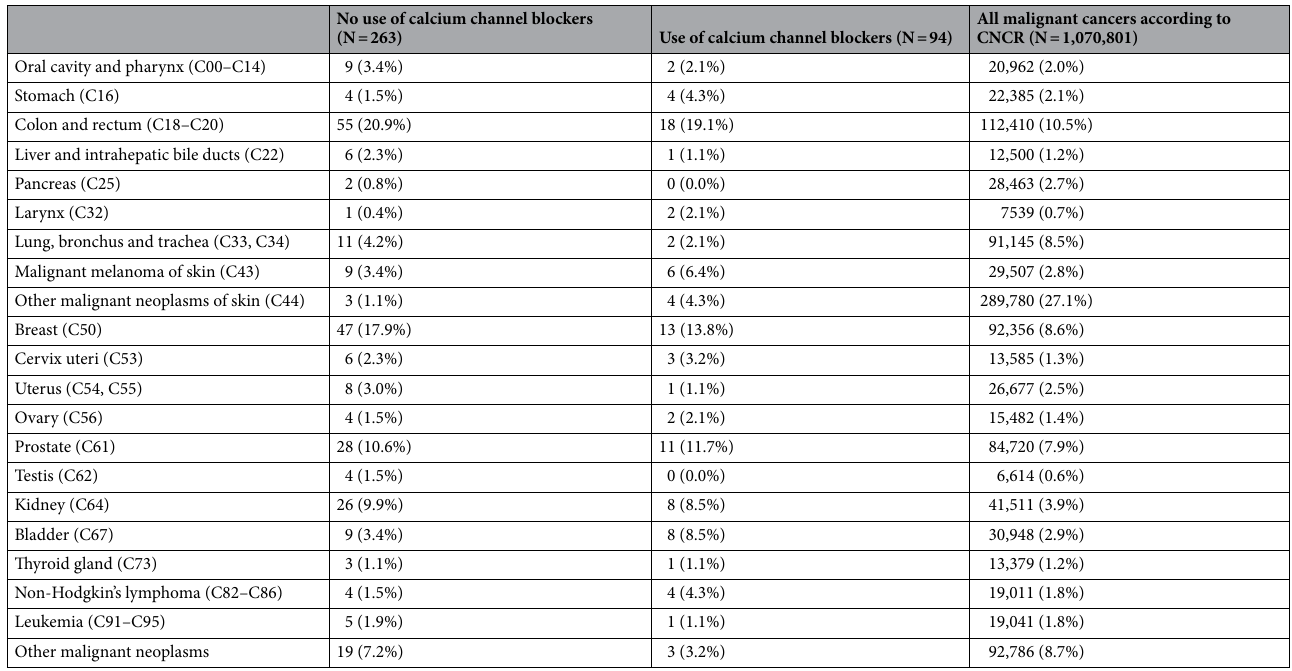
Table 3. Second primary malignancies by the site of diagnosis stratified by the use of calcium channel blockers. Only SPMs with a known date of diagnosis were considered (the date of diagnosis was not available for 7 SPMs). SPM second primary malignancy, CNCR Czech National Cancer Registry